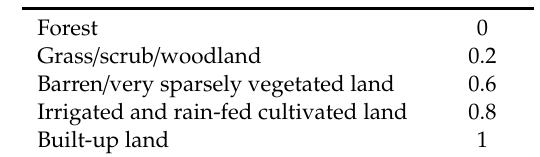
Table 3. The weights that were allocated to the di ff erent land use classes in order to estimate the process a ff ecting surface runo ff